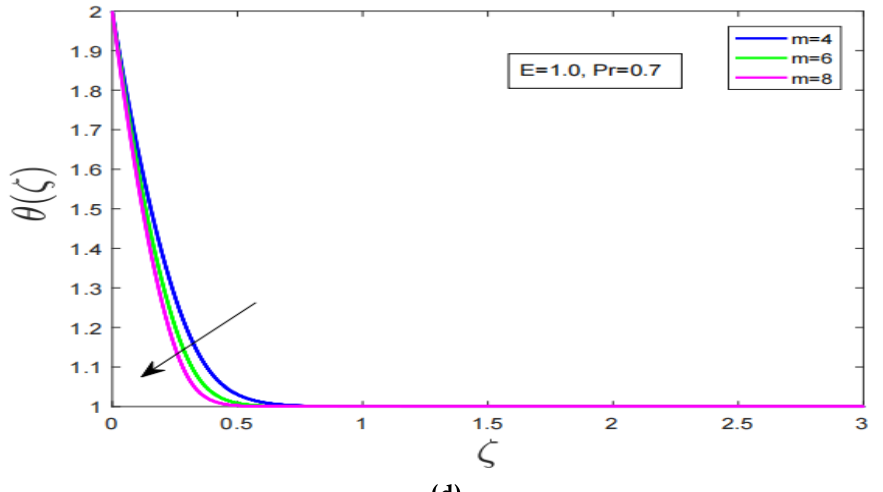
Figure 2. ( a ): Impression of non-linearity effect on velocity profile over stretching and shrinking surface, ( b ): Weissenberg number impact on velocity profile over stretching and shrinking surface, ( c ): Behavior of velocity profile over stretching and shrinking surface under variable viscosity impact, ( d ): Impact of non-linearity effect on temperature profile.